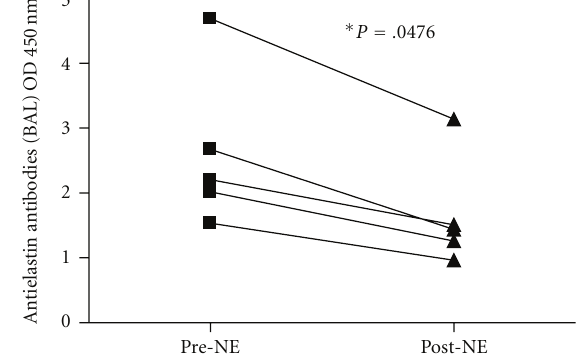
Figure 3: Antielastin antibodies levels pre- and post-NE. Bron- choalveolar lavage fluid antielastin antibodies levels were measured from 5 non-CF individuals pre- and post-NE treatment by ELISA where 1 μ M NE was added to 100 μ L BALF samples for 24